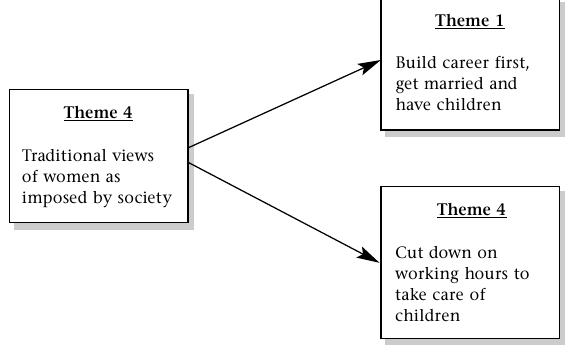
Figure 1: Relation of identified